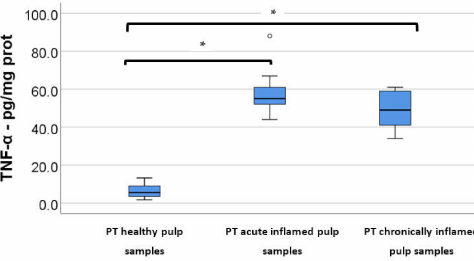
Figure 1. TNF- α protein levels (pg/mg) in the control group versus acute/chronic pulpitis. (* Indicates statistically significant differences). (The circle in the graphic is an indication that an outlier is present.)